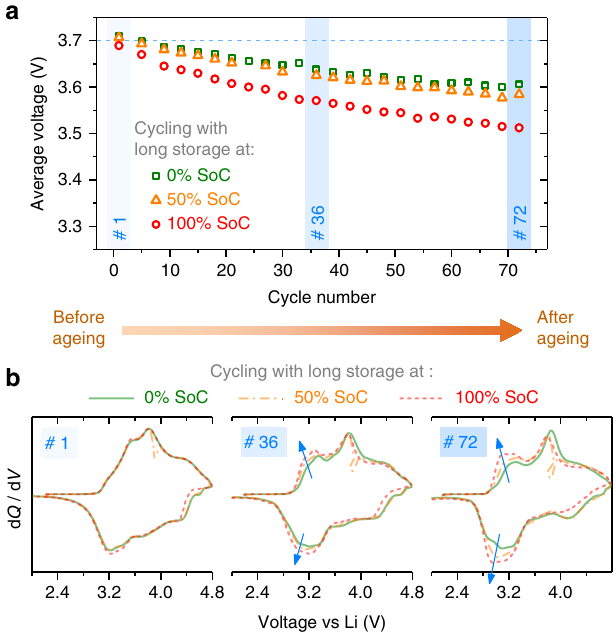
Fig. 6 Role of anionic redox on voltage fade during long-term ageing. a Effect of storage SoC on voltage fade in a controlled ageing experiment of three LR-NMC half-cells. The cells are identically assembled and activated, after which the same cycling conditions are imposed on the three with only one variable differing, which is the SoC where each cell rests during cycling. Average voltage is de fi ned as the mean of average charge and discharge voltages. Cycling window is 2.0 – 4.8 V at 40 mA g − 1 with long (24 h storage) rest periods during every alternate cycle. b The corresponding d Q / d V pro fi les of the above test in the beginning (cycle #1), mid (#36), and end (#72) of ageing. Arrows show the ageing-related growth of low potential d Q /d V peaks. One set of curves has small distortions on charge because of this cell ’ s resting step at 3.9 V (50%